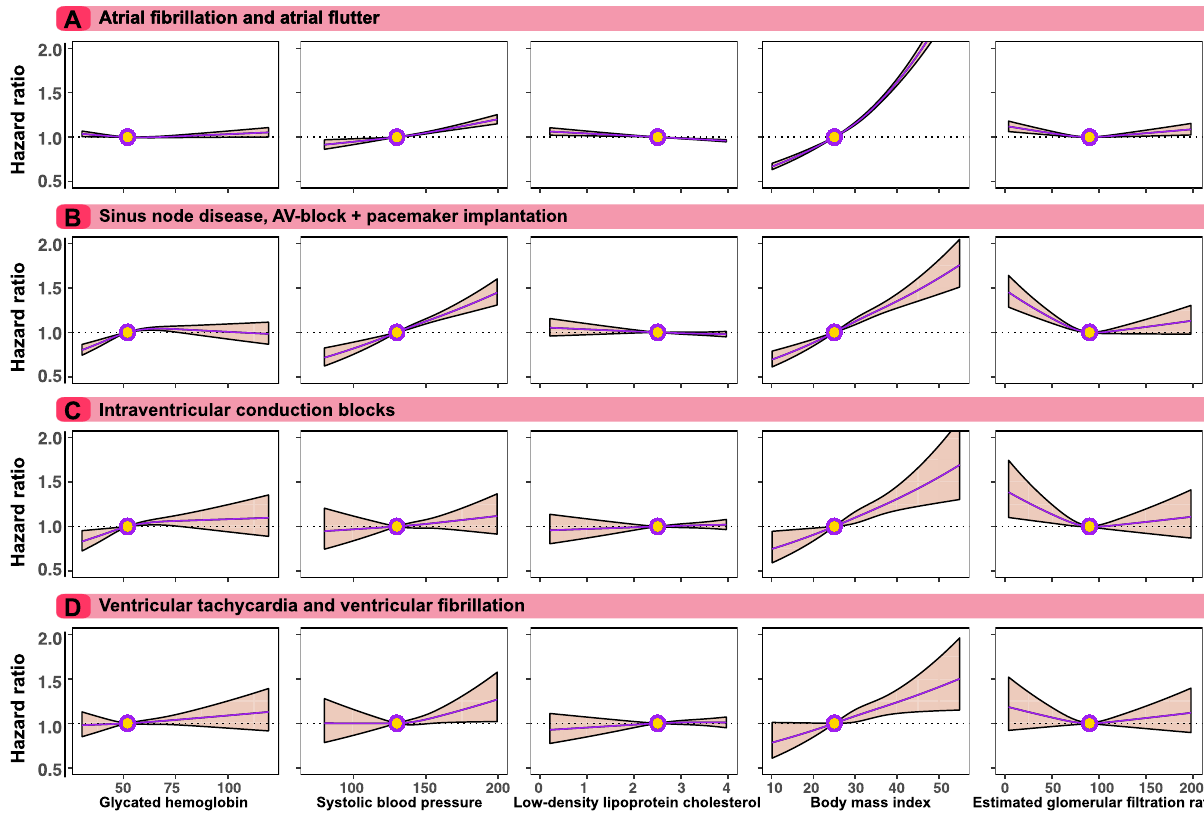
Figure 2. Association between levels of cardiometabolic risk factors for cardiac arrhythmias in patients with type 2 diabetes. We constructed a Cox model for each outcome and applied a prediction function to assess the relationship between selected risk factors and outcomes (Panel A to Panel D). The dark lines indicate the hazard function and the shaded areas 95% confidence intervals. Continuous variables were modeled with restricted cubic splines. The following cut-of levels were used for risk factors: glycated hemoglobin (≥ 7.0% [≥ 53 mmol/ mol]), SBP (≥ 130 mmHg), LDL–C (≥ 2.5 mmol/L [97 mg per deciliter]), BMI ≥ 25 kg/m2 and eGFR ≥ 90 mL/